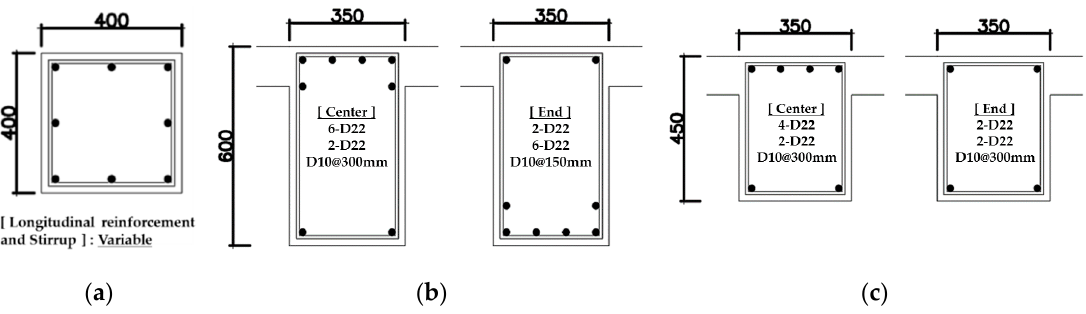
Figure 3. Section details of selected members (unit: mm): ( a ) column; ( b ) girder 1; ( c ) girder 2.